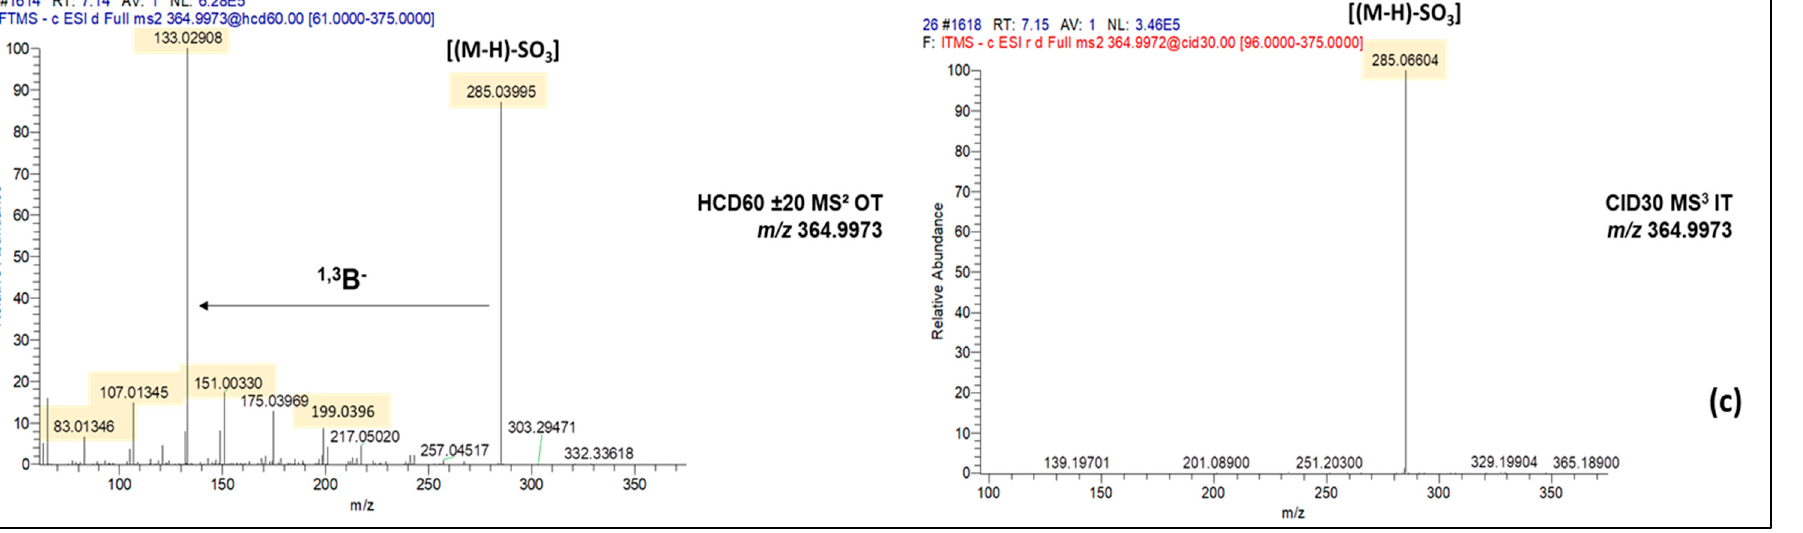
Figure 5. Fragmentation data acquired in HCD60 ± 20 and CID30 MS 2 modes for the unknown candidate flavonoids m/z 505.0988 ( a ), m/z 519.1144 ( b ) and m/z 364.9973 ( c ).